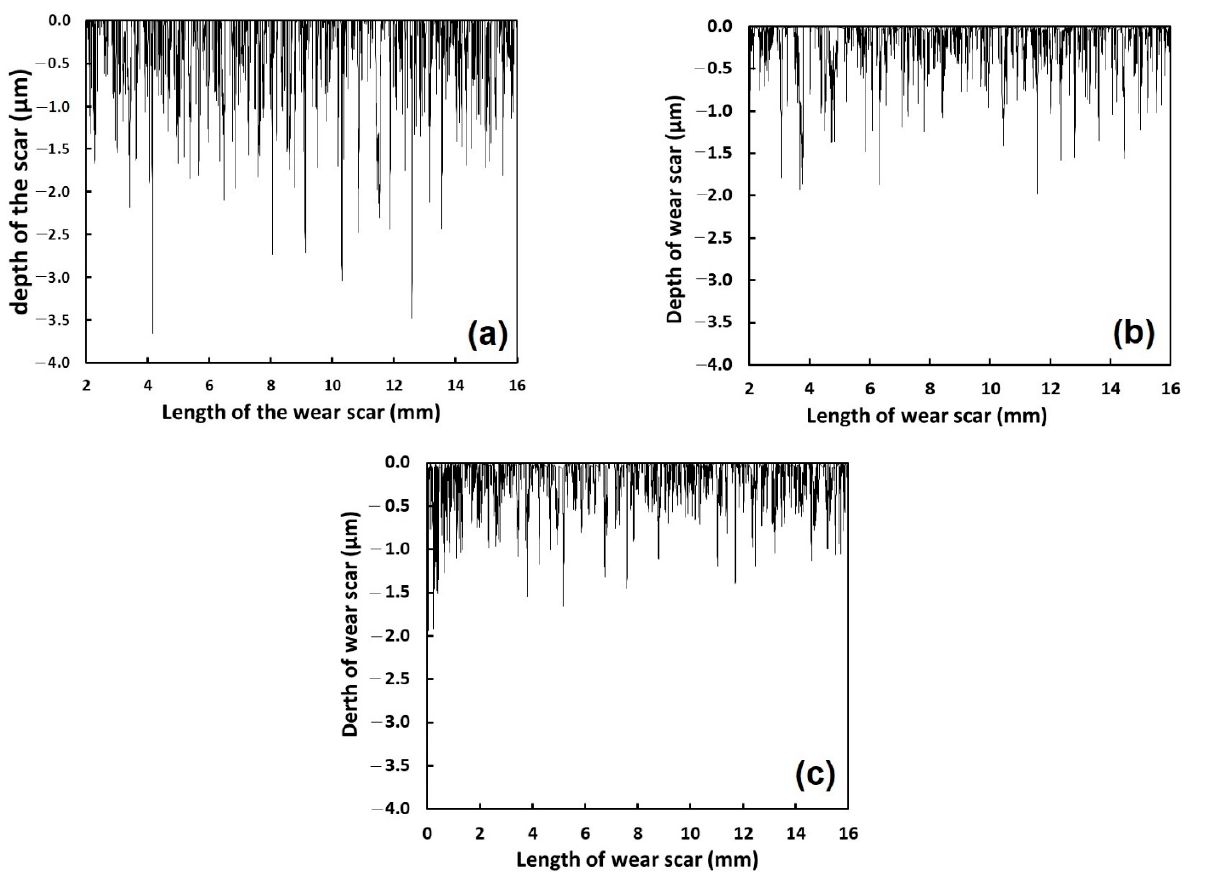
Figure 6. Depth of the wear scar of the sample exposed to a ( a ) carburizing, ( b ) nitriding, and ( c ) boriding process.